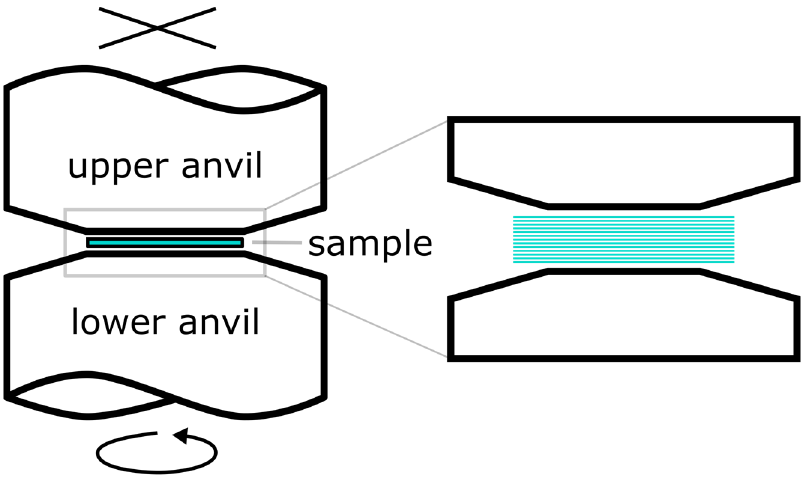
Figure 1. Working principle of HPT with flat top anvils, up to 50 ribbons were stacked between the anvils for HPT consolidation.